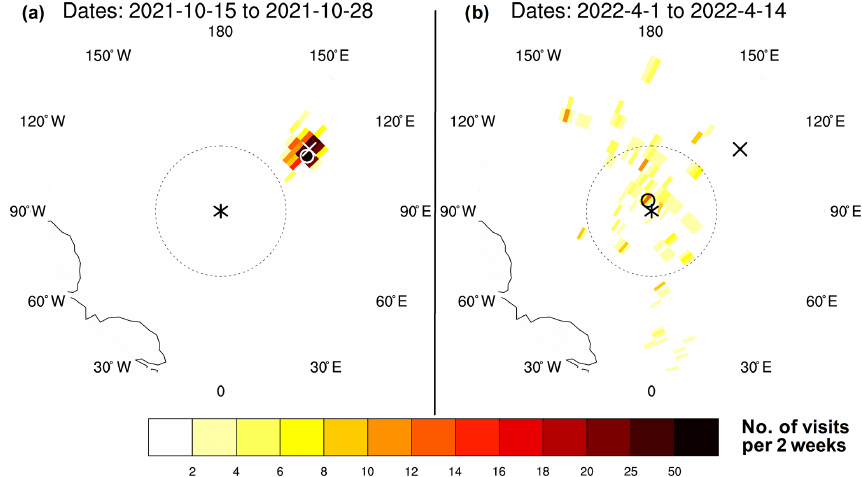
Figure 2. Counts of visits to each grid cell by seasonal tracks in a 2-week period during 15–28 October (a) and 1–14 April (b) . The “X” marks the starting location of the campaign, the circle marks the location of highest counts in the 2-week time period, and the star marks the North Pole. The dashed black line at 87 ◦ N shows, on average, where several current polar-orbiting satellites used for cryospheric research begin to lose coverage due to satellite pole holes. A satellite’s pole hole is unique to its orbit inclination and instrument swath.